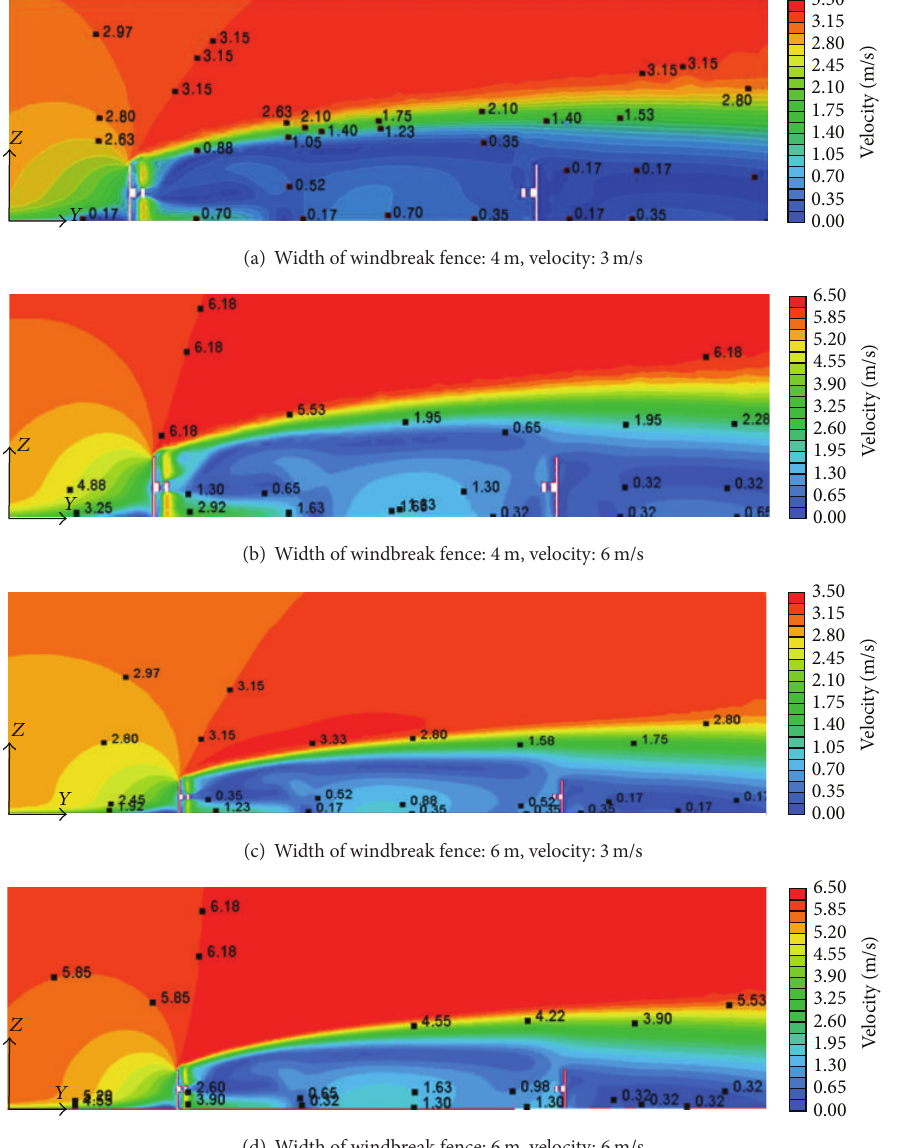
Figure 13: Wind velocity flow inside the fence by